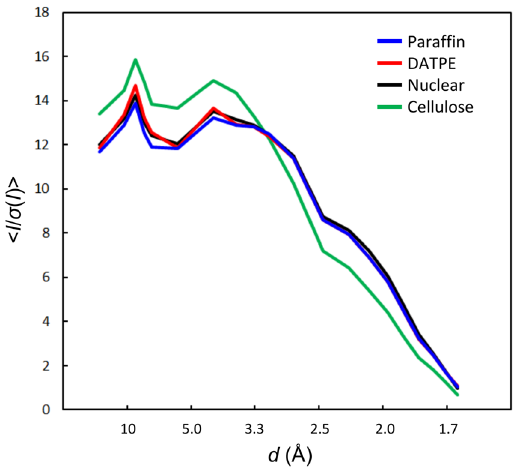
Figure 4. Statistics of I/ σ (I) of 20,000 indexed images from each matrix for proteinase K protein. Four datasets of the paraffin, DATPE, nuclear grease and cellulose matrices are coloured in blue, red, black and green,